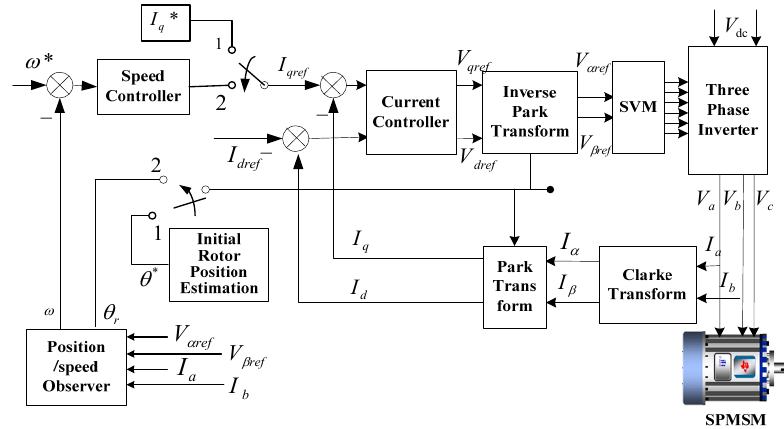
Figure 8. Sensorless control operation block diagram of the SPMSM.